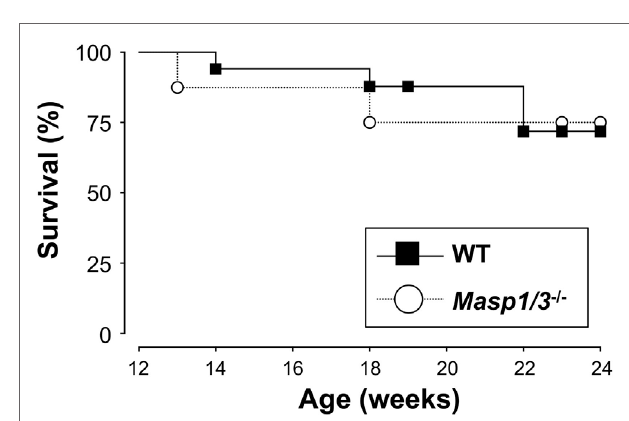
FigUre 8 | Survival curves for WT ( n = 17) and Masp1/3 − / − ( n = 8) MRL/ lpr mice. Mortality was recorded from 12 weeks old to the time at which the mice were sacrificed (24